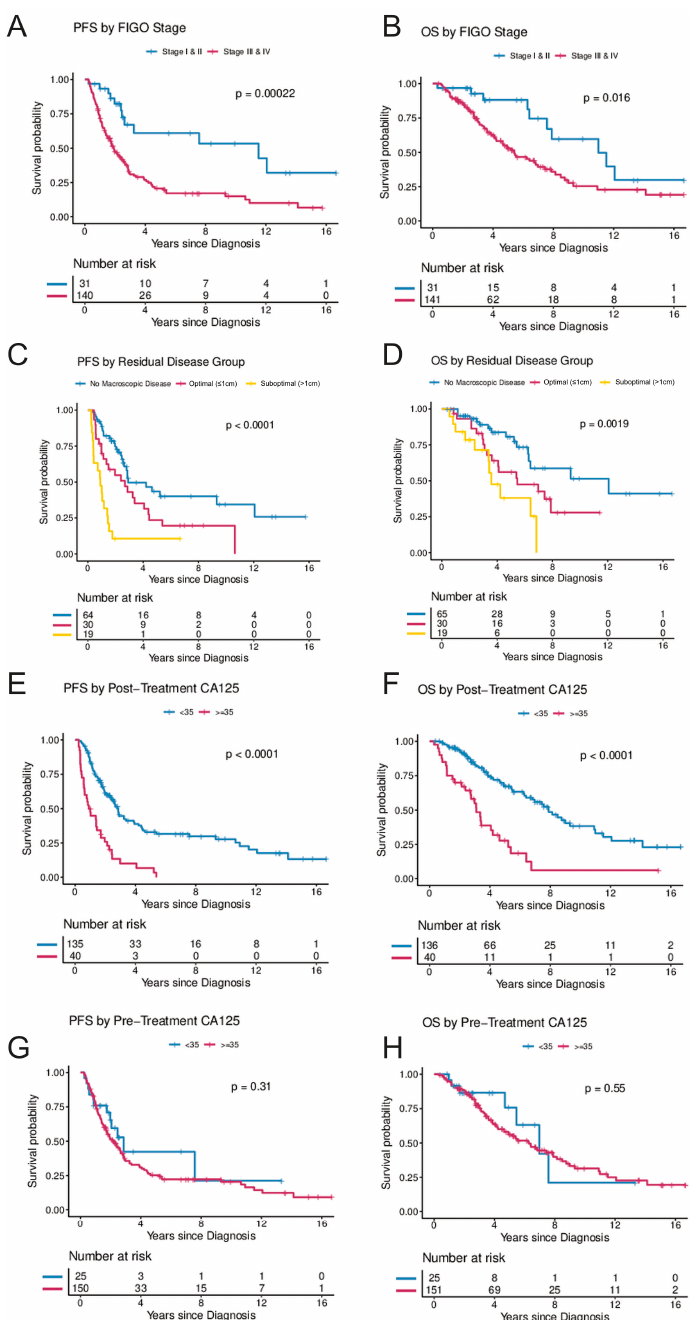
Figure 2. ( A – H ) Progression-free and overall survival by FIGO stage, residual disease, and post- treatment CA-125 and pre-treatment CA-125. ( A , B ) illustrate progression-free and overall survival by FIGO stage (Stages I and II combined vs. Stages III and IV). ( C , D ) illustrate progression-free and overall survival by residual disease following cytoreductive surgery (no visible macroscopic disease vs. macroscopic disease ≤ 1 cm vs. macroscopic disease >1 cm). ( E , F ) illustrate progression-free and overall survival by CA-125 levels following treatment (<35 vs. ≥ 35) and ( G , H ) illustrate progression- free and overall survival by CA-125 levels at diagnosis (<35 vs. ≥ 35). The Kaplan–Meier method with log-rank tests was used to examine survival differences. p -values < 0.05 were considered statistically significant. Individuals at risk are shown in the legends. Abbreviations: OS, overall survival; PFS, progression-free